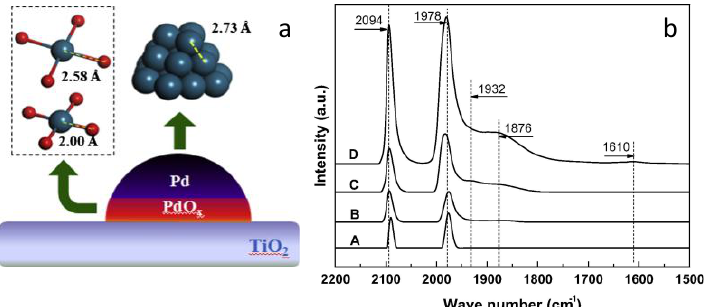
Figure 7. ( a ) Structural model of the Pd/TiO 2 catalyst. ( b ) In situ DRIFTS of CO adsorption over different catalysts at room temperature in an Ar flow (50 mL/min): A: 1.0% Pd, B: 2.0% Pd, C: 3.0% Pd, and D: 5.0% Pd. Reprinted from J. Catal., 321, L. Ouyang, P. Tian, G. Da, X. Xu, C. Ao, T. Chen, R. Si, J. Xu, Y. Han, The origin of active sites for direct synthesis of H 2 O 2 on Pd/TiO 2 catalysts: Interfaces of Pd and PdO domains, 70–80, Copyright (2018), with permission from